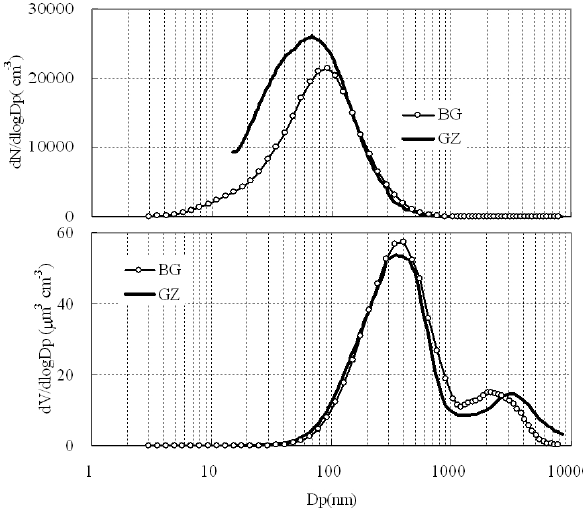
Fig. 1. Average particle number and volume size distributions at GZ and BG during the whole